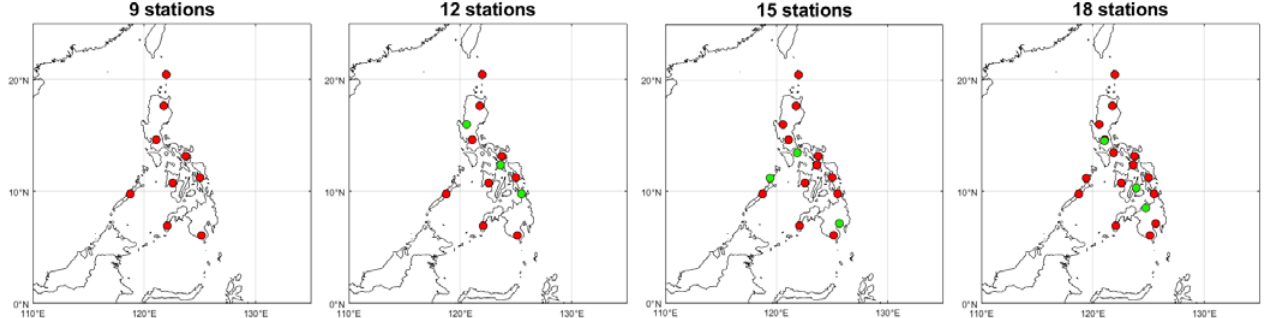
Figure 3. Distribution of variable GNSS receiver stations used. Stations in green indicate the additional stations for that parameter. 9 stations include PBAS, PGEN, PILC, PIMO, PLEG, PPPC, PTAC, PTUG and PZAM. 12 stations include the 9 stations plus PMAS, PSUR and PURD. 15 stations include the 12 stations plus PDAV, PMOG and PNDO. 18 stations include all receiver stations initially considered for this study based on Figure 1.